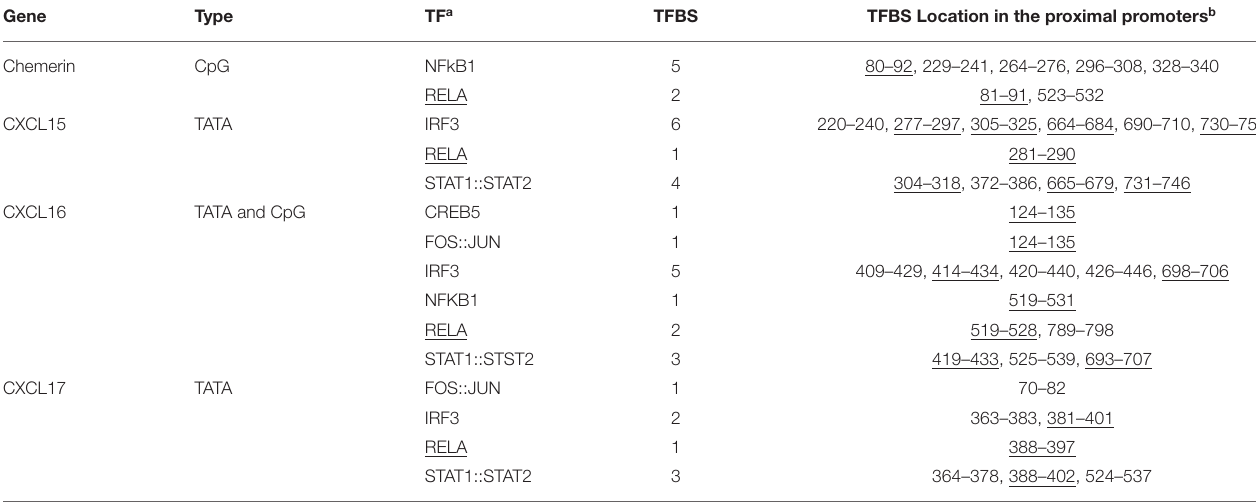
TABLE 8 | The numbers and locations of predicted transcription factor (TF) binding sites (TFBS) in the proximal promoters (CpG island or 500 bp upstream and 250 bp downstream of TATA box) of chemerin, CXCL15, CXCL16, and CXCL17 genes.